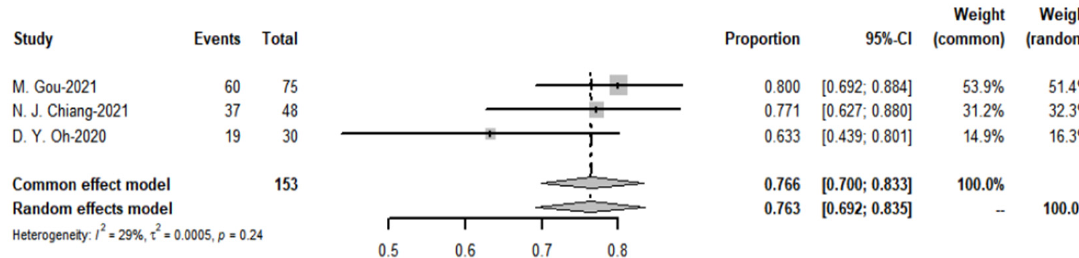
Figure 20. Disease control rate of targeted therapies and funnel plot.